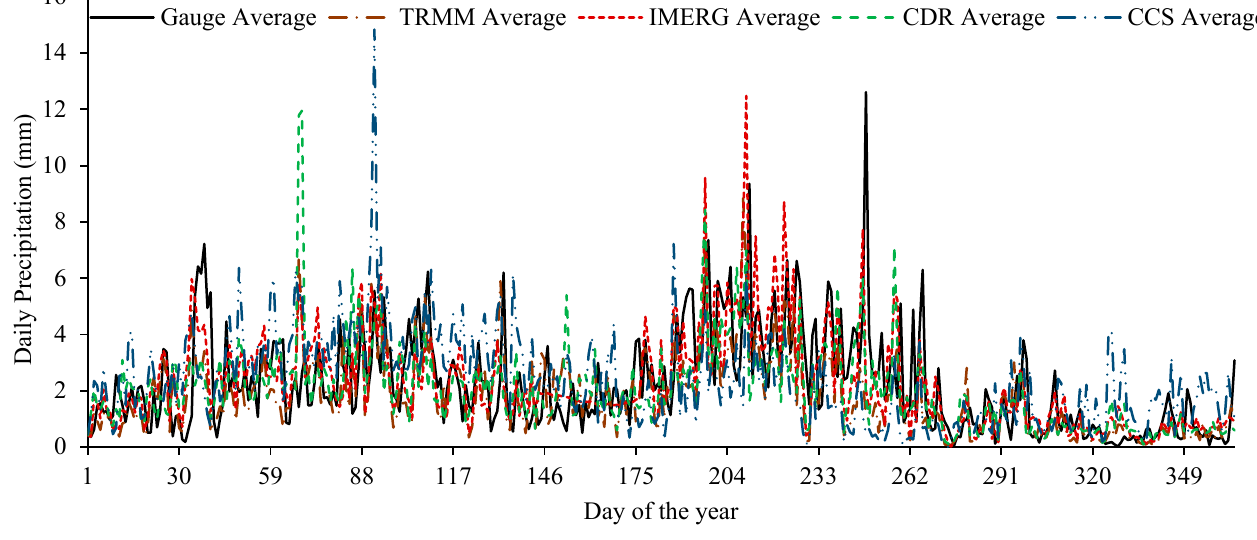
Figure 5. Temporal variability of all SBPD and gauge estimation.